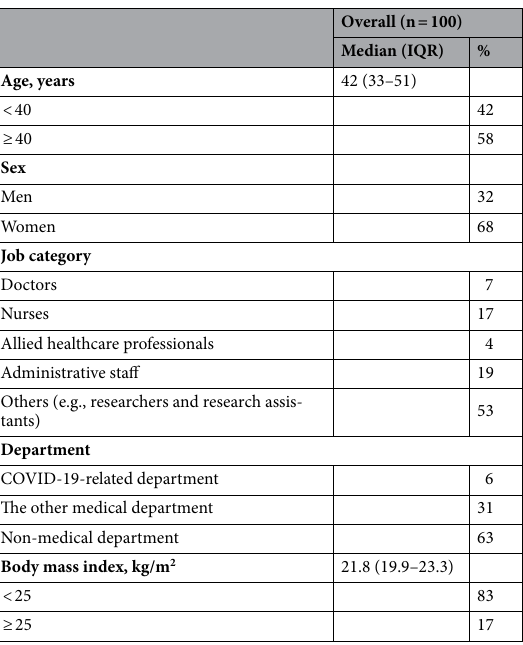
Table 1. Participants’ characteristics (n = 100). IQR: interquartile range.